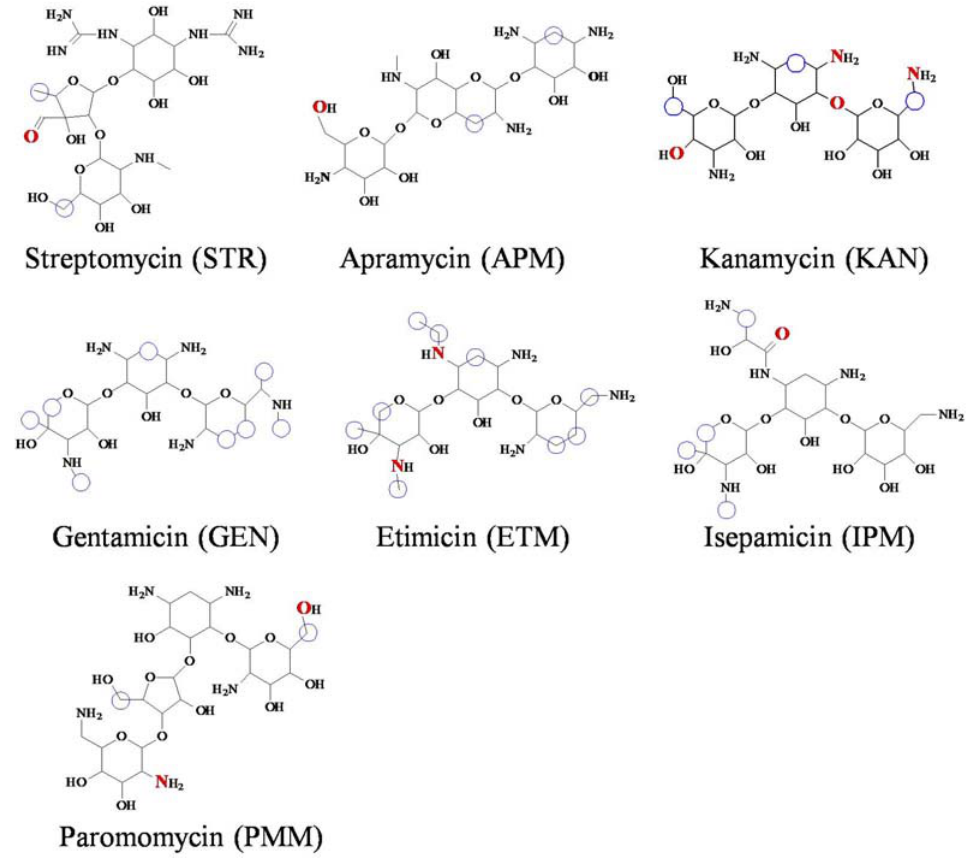
Figure 1. Molecular structures of the 7AGs (the atomsof red color interacted with the receptor via a hydrogen bond;the atoms circled with blue rings interacted with the receptor via hydrophobic in ‐teraction).